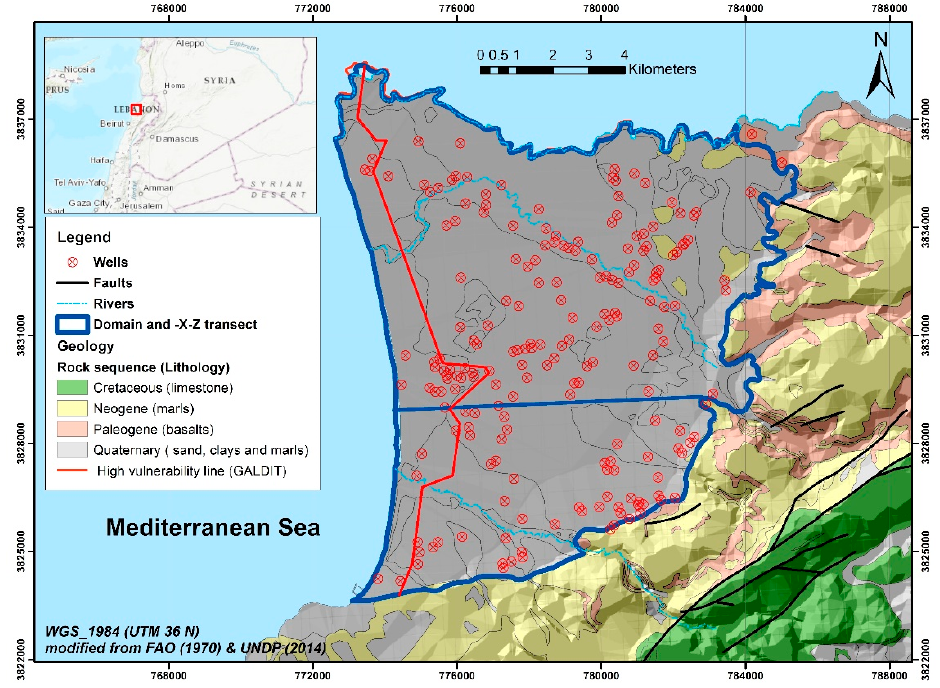
Figure 9. Situation map of the Akkar plain in Northern Lebanon showing the lithology of outcropping formations, domain boundaries, the selected vertical X-Z transect for vulnerability assessments to SWI, and the high vulnerability line determined by GALDIT [70]. Table 2. Physical parameters used for the specific vulnerability assessments in the Akkar aquifer case study (Lebanon).